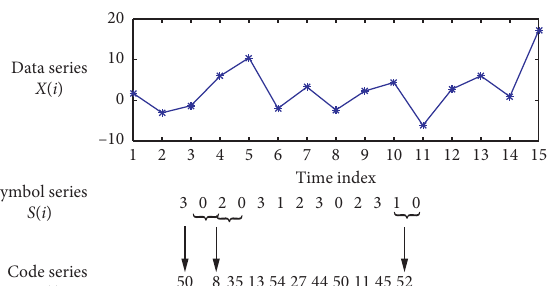
Figure 1: Process of